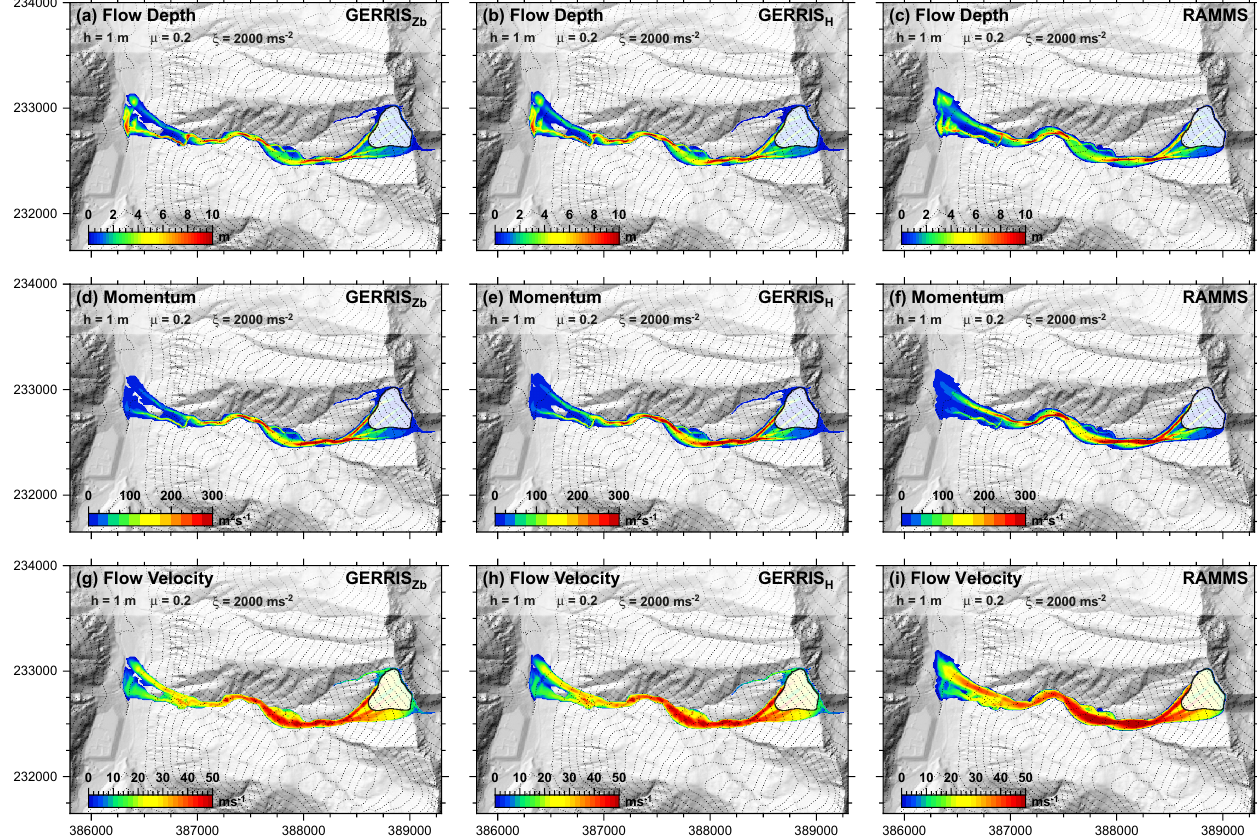
Figure 8. Maximum values of the characteristic properties of a hypothetical avalanche flowing along a curved and twisted thalweg on a real topography (Felbertal, Austria), based on the numerical solutions of GERRIS Zb , GERRIS H , and RAMMS for the same model set-up. Fluid rheology ( µ = 0 . 2, ξ = 2000ms − 2 ) and spatial resolution for the three different numerical models are the same. (a–c) maximum flow depth, (d–f) maximum momentum, (g–i) maximum flow